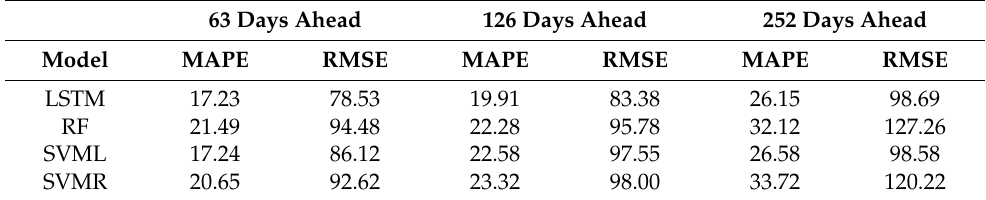
Table 2. Error rates in each model for validation